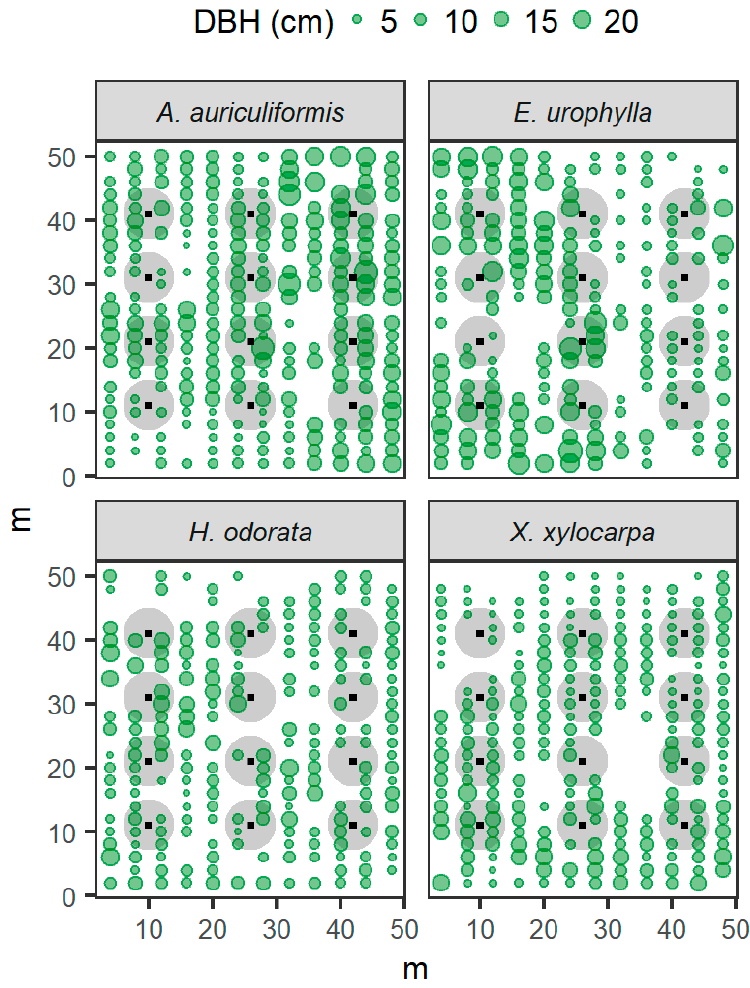
Figure 2. Distribution of soil respiration measurements within each sample plot. The tree stem position is shown with green dots, which are scaled according to their DBH. Black squares indicate the location of soil respiration measurements. Grey circles with a 5 m radius highlight trees considered in the subsequent analysis.